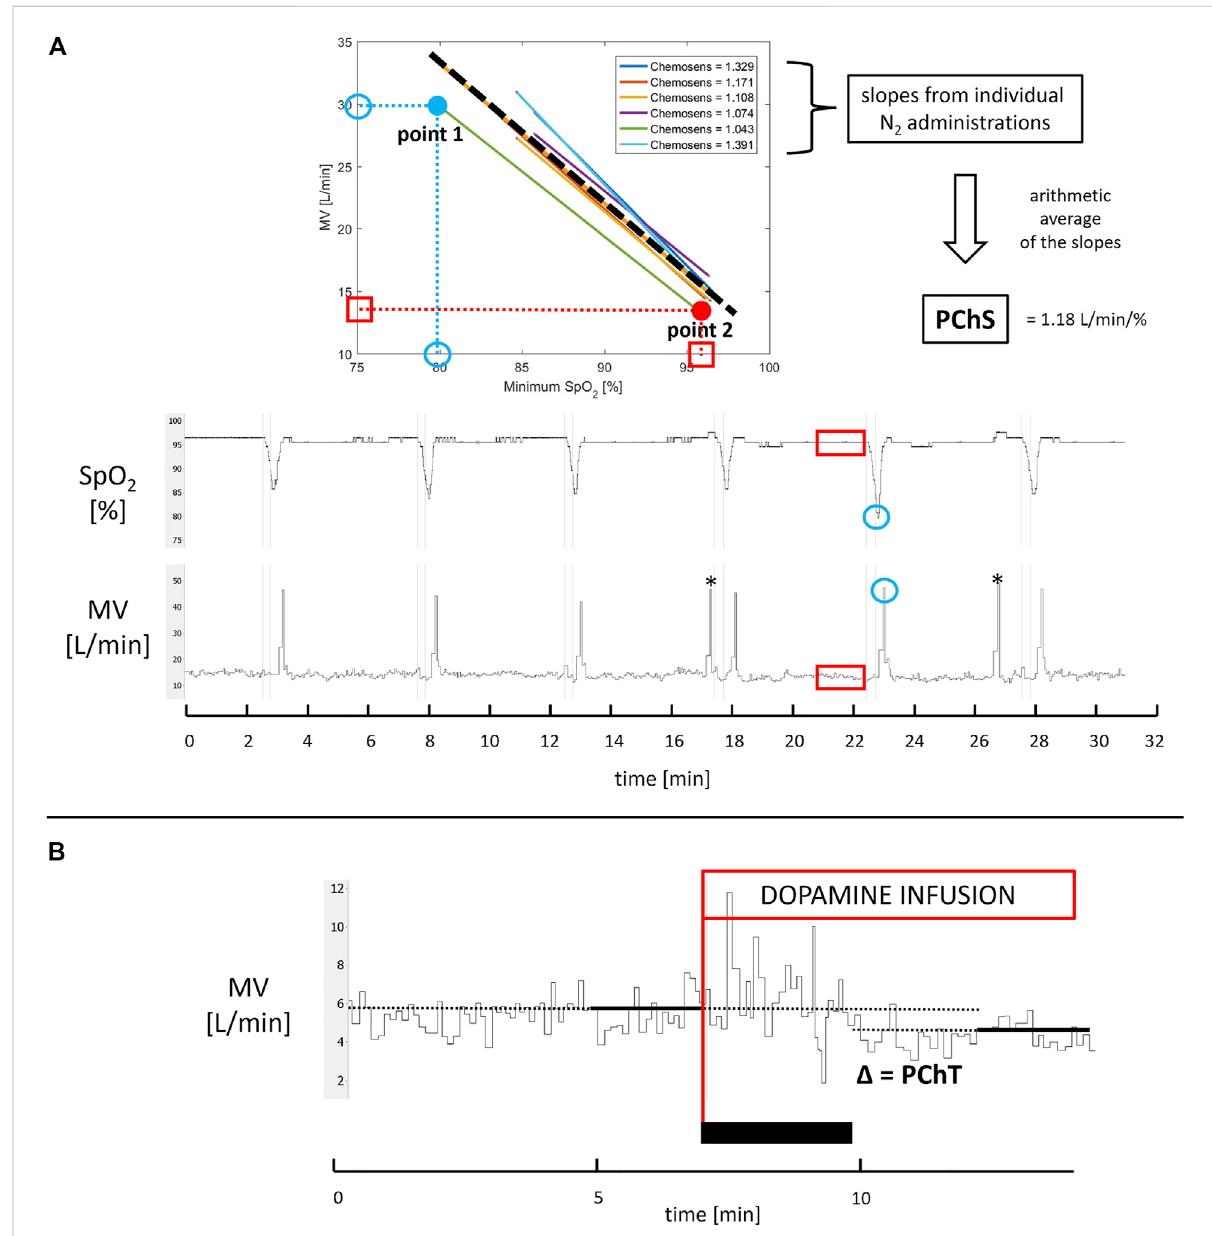
Assessment of PChS and PChT. Panel (A) For each N 2 administration (thin vertical lines marking start and stop of N 2 exposures) minimal SpO 2 and corresponding maximal minute ventilation (MV) averaged from three consecutive breaths were identi fi ed (blue circles; note that MV tracing is recorded breath-by-breath) to provide point 1. Next, 90 s recordings of SpO 2 and MV directly preceding N 2 administration were averaged toprovidepoint2(redsquaresandrectangles).Theslopeofregressionfunctionlinkingpoint1andpoint2wascalculatedforeachN 2 exposure. Theaverageofallslopes(dashedthickline)constitutesPChS.*indicatesincidentalgaspsignoredinPChSassessment.Panel (B) PChTwascalculated as an absolute difference between MV averaged from 2 min directly preceding initiation of low-dose dopamine infusion (red line) and MV obtained from 2 min of recording during dopamine infusion when ventilatory and hemodynamic parameters stabilized (the black rectangle indicates stabilization phase when dopamine does not exert its full action